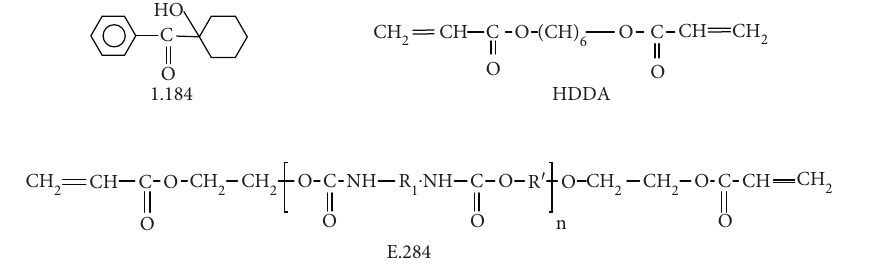
Figure 1: Chemical structure of the photocurable resin system.